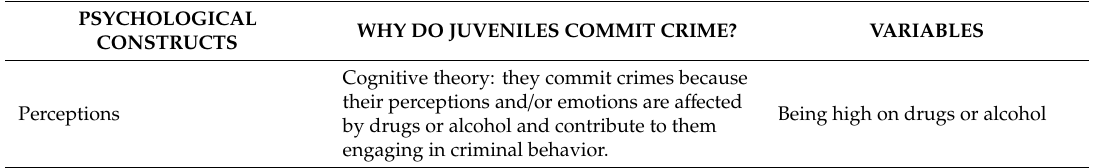
Table 1. Psychological explanations of